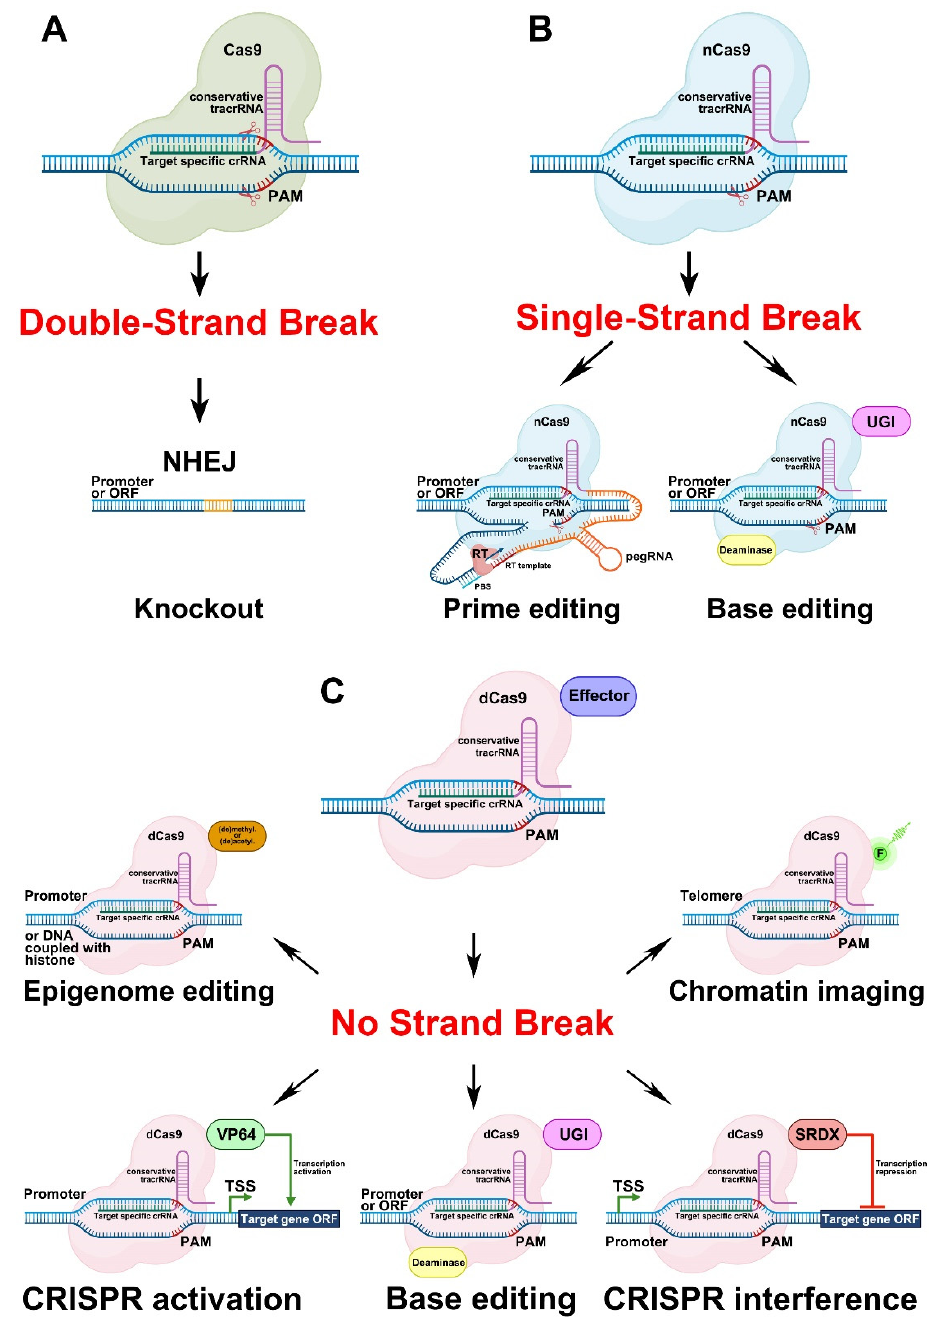
Figure 5. Types of the CRISPR/Cas9 systems. ( A ) System based on the Cas9 form producing a double-strand break, NHEJ—non-homologous end joining. ( B ) Approaches using nickase Cas9 (nCas9) activity resulting in a single-strand break, pegRNA—prime editing guide RNA comprised of a target specific crRNA, a conservative tracrRNA, a PBS—primer binding site, an RT template—RNA template for reverse transcription (direction of reverse transcription indicated by a dark blue arrow). The linker joining crRNA and tracrRNA with PBS and the RT template is indicated in orange. RT—reverse transcriptase; UGI—uracil-DNA glycosylase inhibitor domain. ( C ) Techniques using the catalytically inactive (dead) form of Cas9 (dCas9); types of effectors used in dCas9-based systems: (de)methyl.—methyltransferase or demethylase for epigenetic modifications of DNA; (de)acetyl.—acetyltransferase or deacetylase for epigenetic modifications of histones; F—fluorescent protein; VP64—tetrameric repeat of the minimal activation domain of herpes simplex viral protein 16; UGI—uracil-DNA glycosylase inhibitor domain; deaminase—cytidine or adenosine deaminase; SRDX—SUPERMAN Repression Domain X. For systems based on Cas9 and